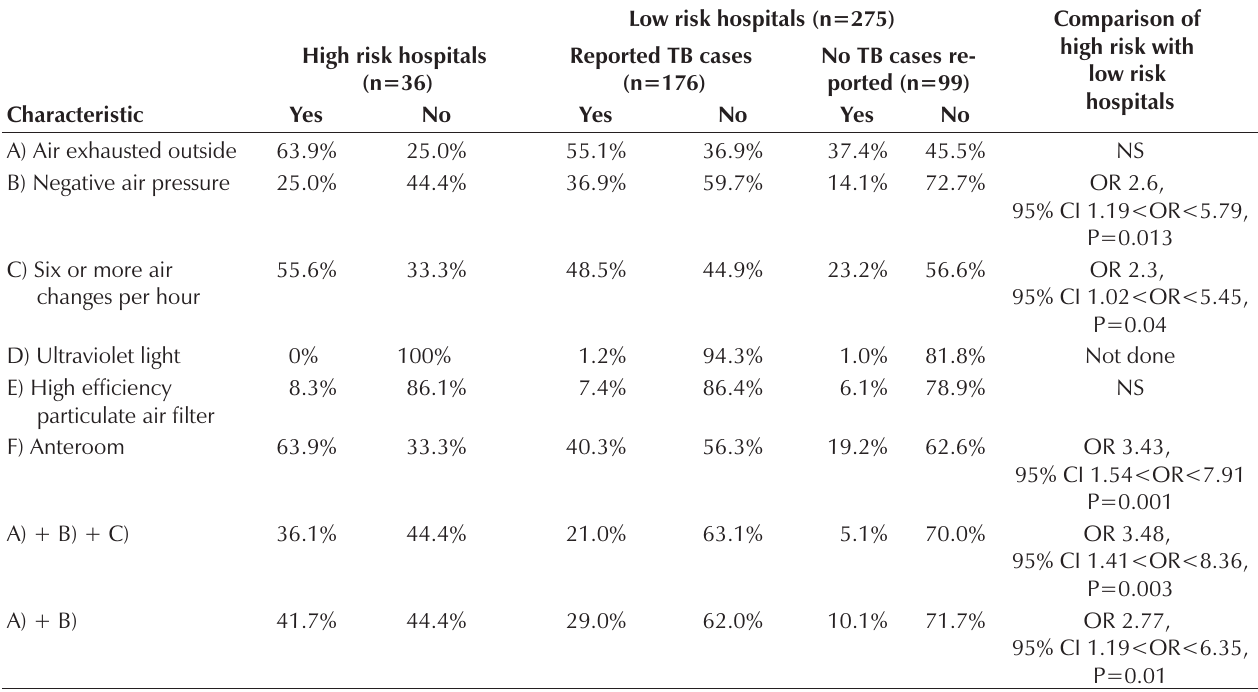
Percentage of ward isolation room environmental and engineering controls available in high and low risk hospitals Low risk hospitals